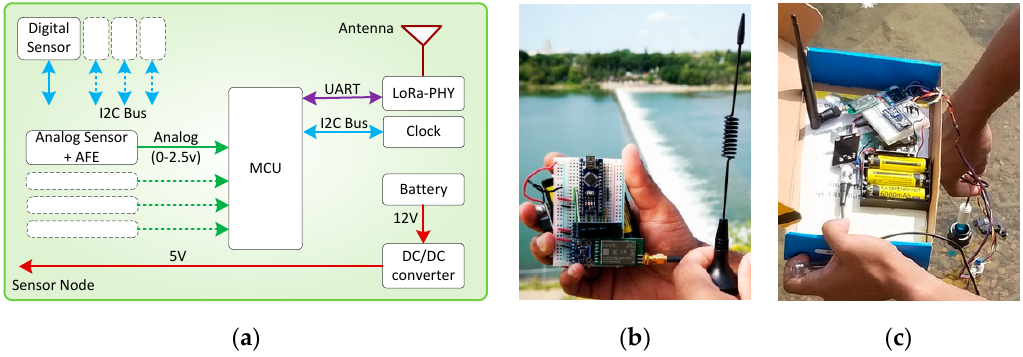
Figure 8. ( a ) Hardware block of SN, ( b ) RN with air-quality sensors, and ( c ) SN with pH and turbidity sensors.